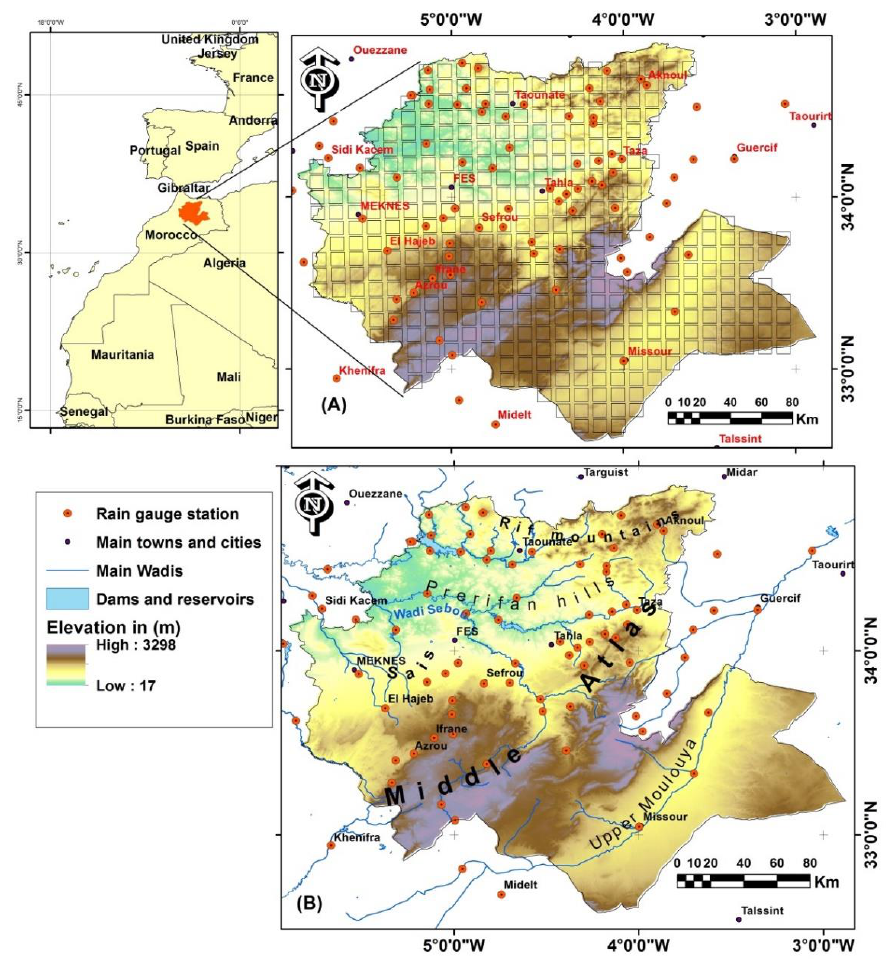
Figure 1. ( A ) Situation map of the Fez-Meknes region, rain gauges and visualization of the grid with a spatial resolution of 10 km; ( B ) the same map with more physiographic features. The Fez-Meknes region is home to 4.4 million inhabitants or 12.5% of the